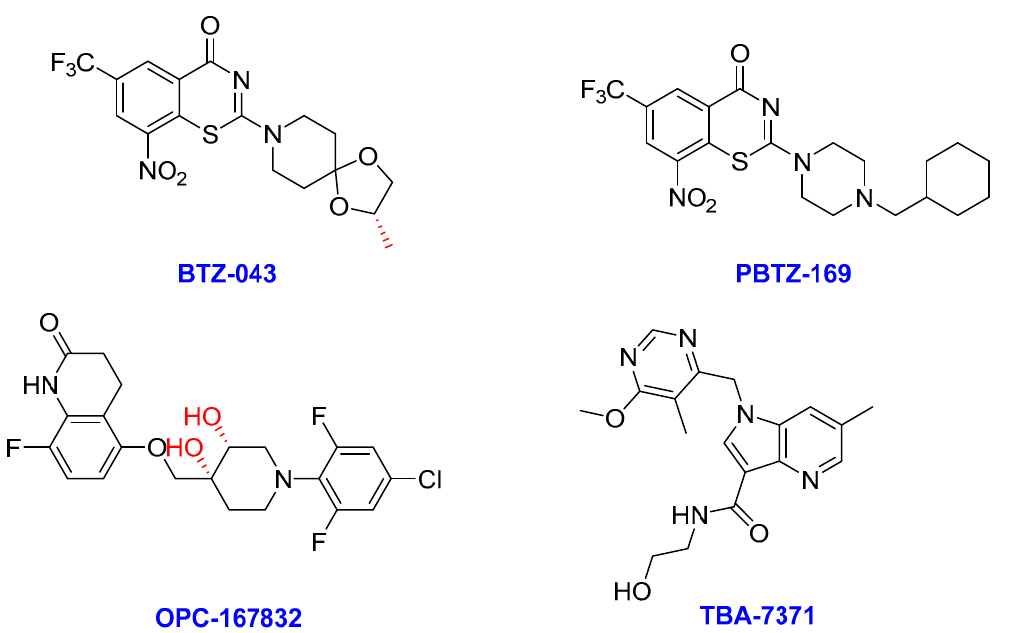
Figure 7. The chemical structures of novel DprE1 inhibitors under clinical development for Mtb treatment.